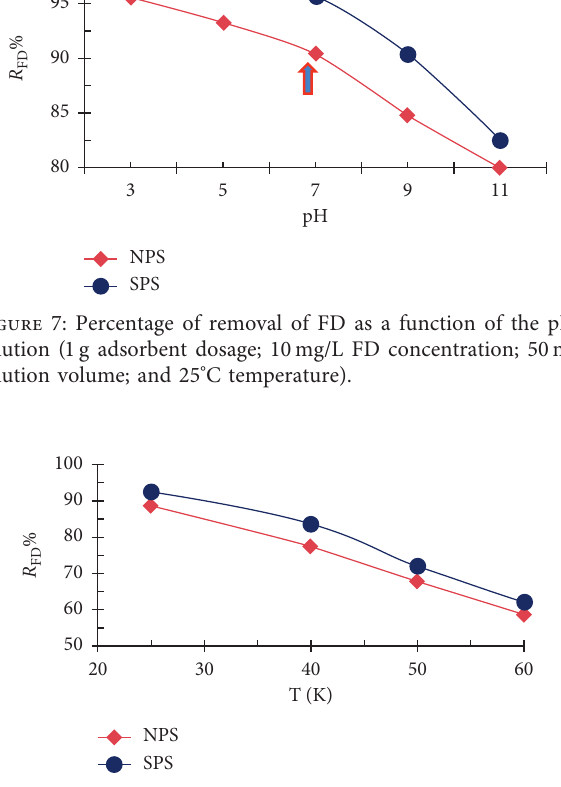
Figure 8: Effect of temperature on the percentage of FD removal by NPS and SPS (1g adsorbent dosage; 10mg/L concentration of FD; 50ml solution volume; and 3h contact